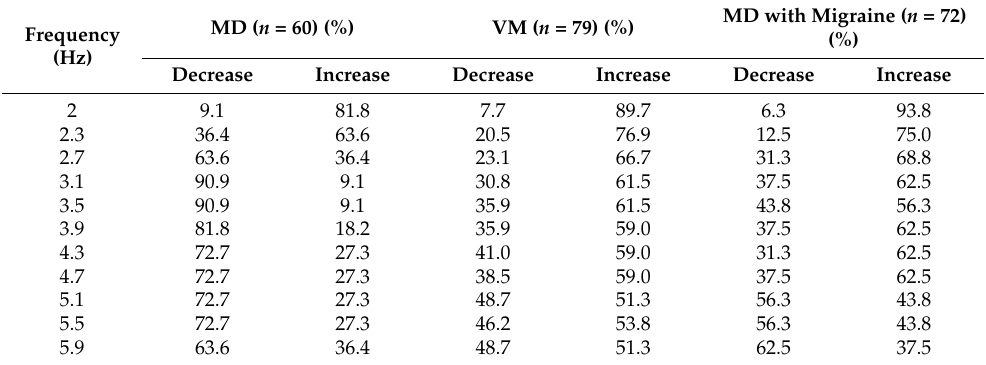
Table 3. Abnormal rate in different frequencies of the horizontal gain in the MD, VM and MD with migraine patients.